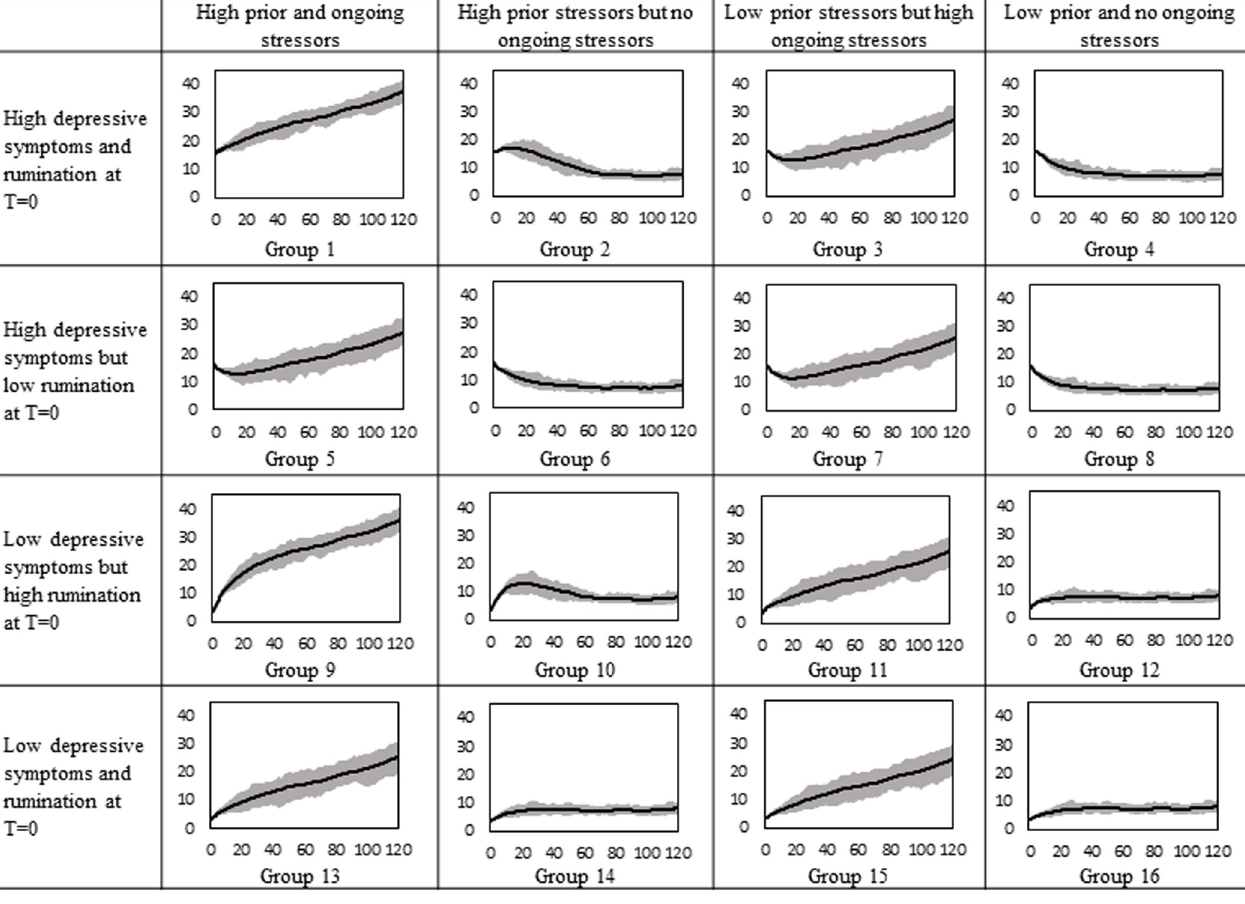
PLOS ONE | https://doi.org/10.1371/journal.pone.0276441 October 27,